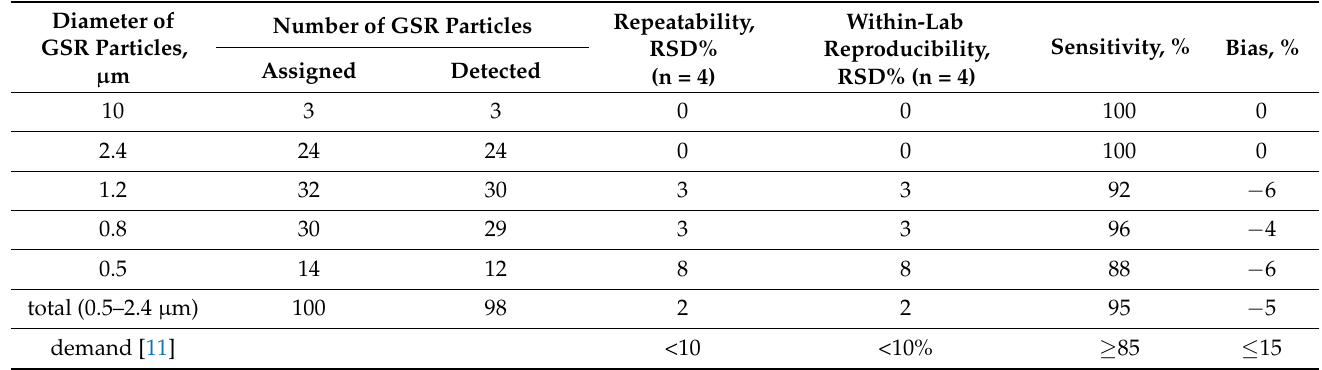
Table 4. SEM/EDS method performance among the groups of PbSbBa GSR particles in the ENSFI